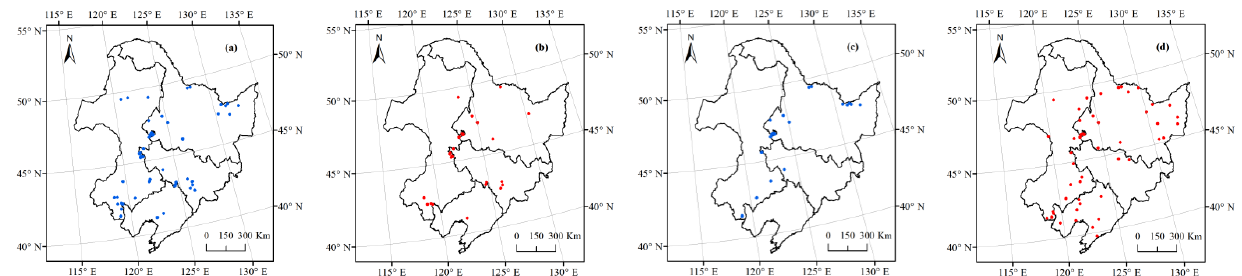
Figure 6. Comparison of the spatial distribution of fire points in Northeastern China from MODIS observations (blue points) and BPNN forecasting (red points). ( a , b ) use the model described in Section 3.1.2 to forecast fire points from 2018–2020, and ( c , d ) show the data from 2018–2019 that were used to forecast fire points in 2020, after adding the anthropogenic management and control policy as input data.